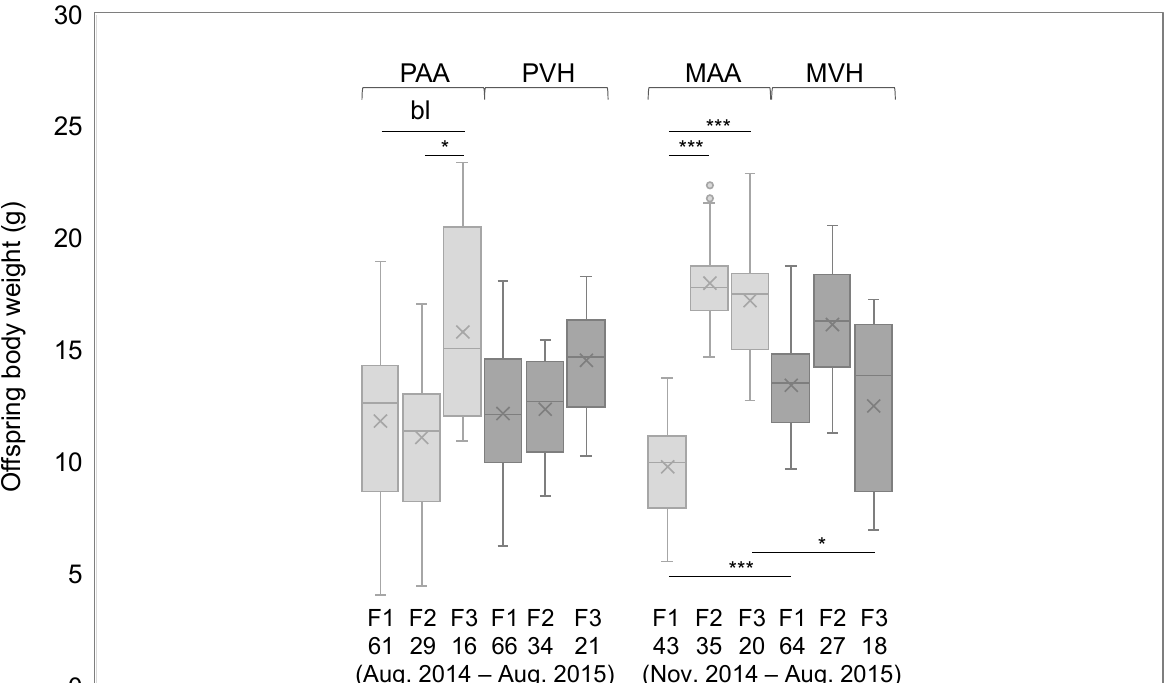
Figure 3. Offspring body weight of mice supplemented paternally or maternally for three consecutive generations. Horizontal lines indicate significant differences between each experimental group; bl p < 0.1, * p < 0.05, *** p < 0.001; supplemental period and n of each group is indicated under each bar graph; PAA and MAA: paternal and maternal AA supplementation, respectively; PVH and MVH: paternal and maternal VH supplementation, respectively.